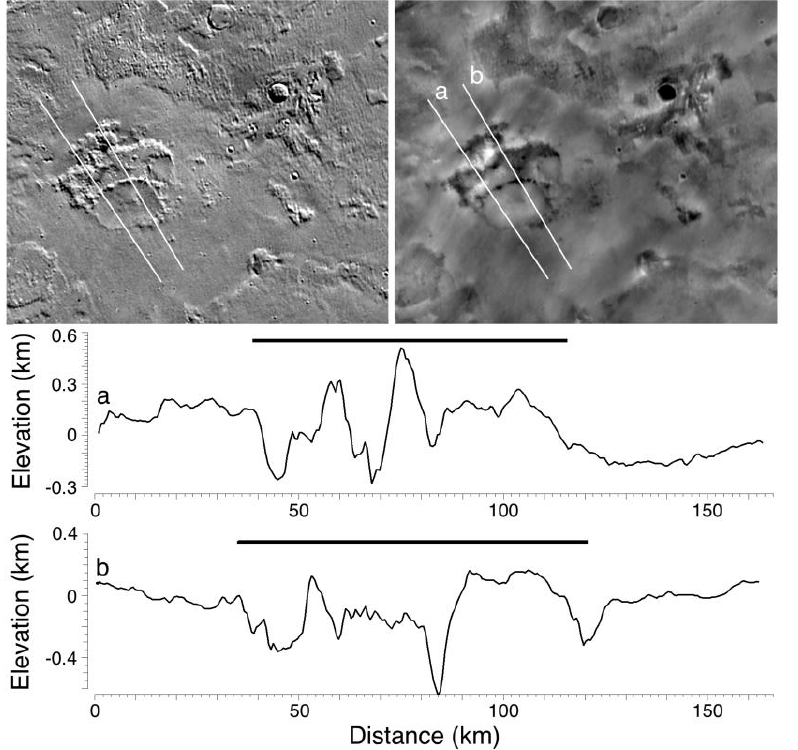
Figure 17. Topographic profiles across Leviathan Patera, highlighting scarp-bounded margin, broad domes in parts of the floor and high promontory on northwest patera floor. ( Top ) Image mosaic and ( right ) DEM scene widths are ~300 km, from SG-PC-DEM in Figure 8. Note different horizontal scales in